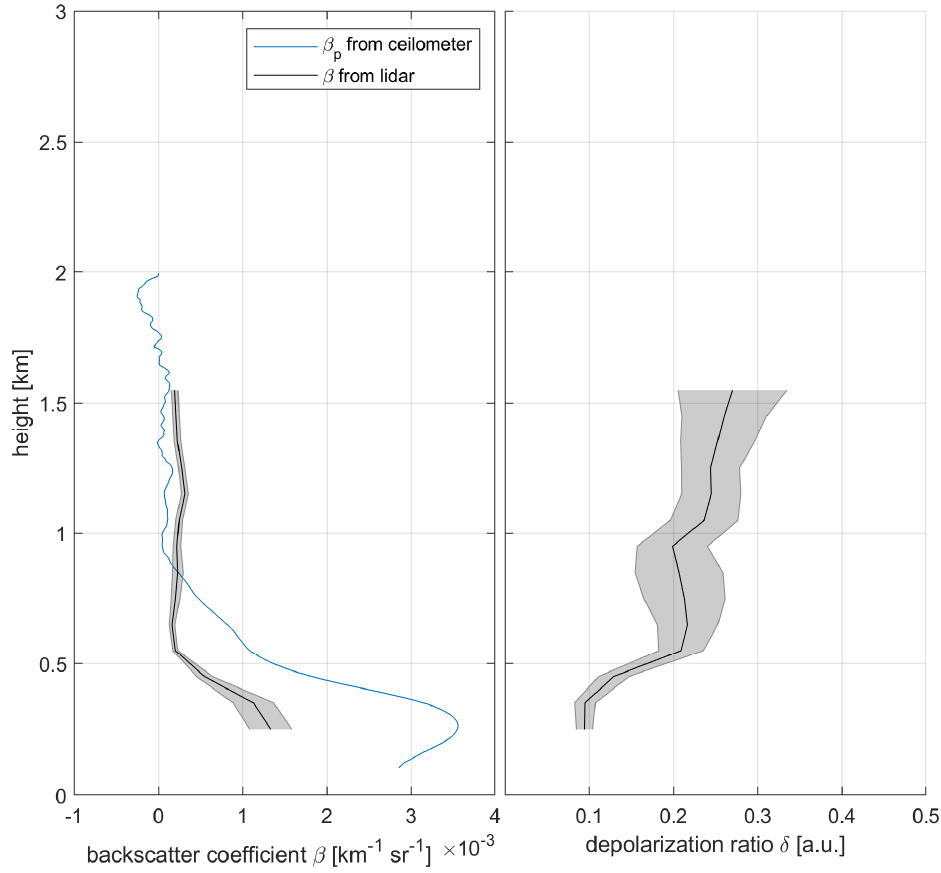
Figure 15. 30–min-average (solid black line) of lidar β [km − 1 sr − 1 ] and ceilometer (blue line) retrieved β [km − 1 sr − 1 ] at 6:20 on 1 August, 2019, Reykjavik. The shaded area shows the standard deviation. Right panel: lidar δ for the same period. The lidar data is filtered by CNR.